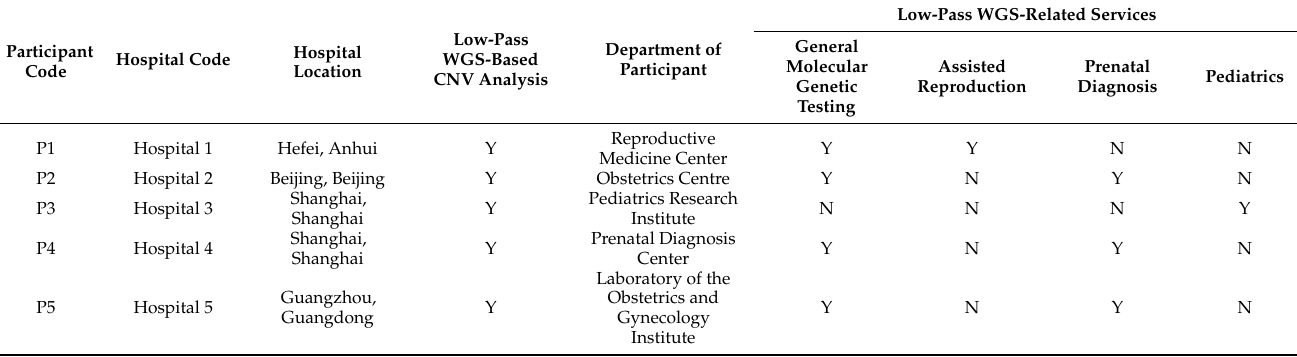
Table 1. Characteristics of the 24 participating